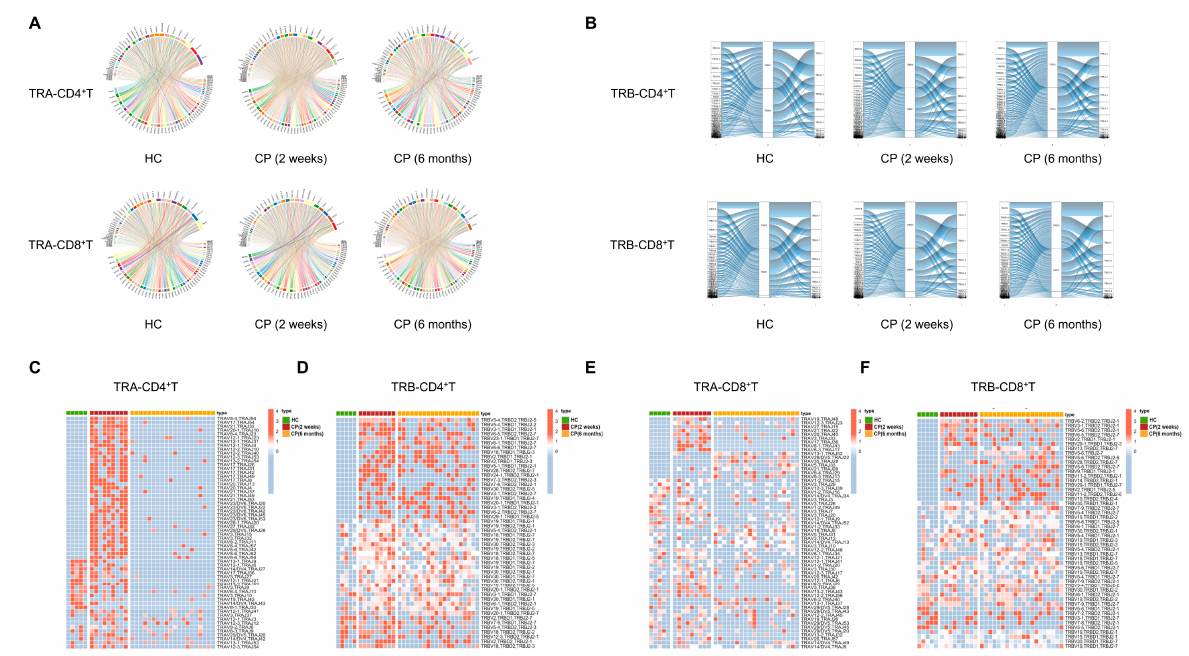
Figure 3. The V, D, and J gene usage comparison of TCR α (TRA) and TCR β (TRB) chain in the convalescent COVID-19 patients. ( A ) The Circos plots show the difference between CD4 + T cell TRA-VJ (top) and CD8 + T cell TRA-VJ (bottom) among different COVID-19 patients with 2-week and 6-month convalescence phase (CP) and healthy controls (HC). ( B ) Sankey diagram shows the recombinant pattern of TRB VDJ in the CD4 + T (top) and CD8 + T cell (bottom) among different convalescence COVID-19 patients (CP) and healthy controls (HC). ( C – F ) A histogram of V(D)J gene recombinant pattern of TRA and TRB in CD4 + T and CD8 + T cells of COVID-19 patients (CP) with 2-week and 6-month-convalescence phase compared with healthy controls (HC). ( C ) TRA in CD4 + T cells. ( D ) TRB in CD4 + T cell. ( E ). TRA in CD8 + T cells. ( F ) TRB in CD8 + T cell.